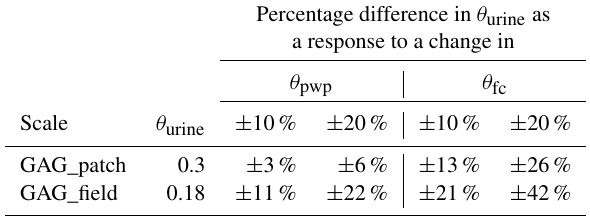
Table 5. The maximum space in the NH 3 source layer that can be filled by the incoming liquid ( θ urine ) in the baseline experiments with GAG_patch and GAG_field, and the percentage it changes when θ fc (field capacity) and θ pwp (permanent wilting point) are modified by ± 10 and ± 20%.